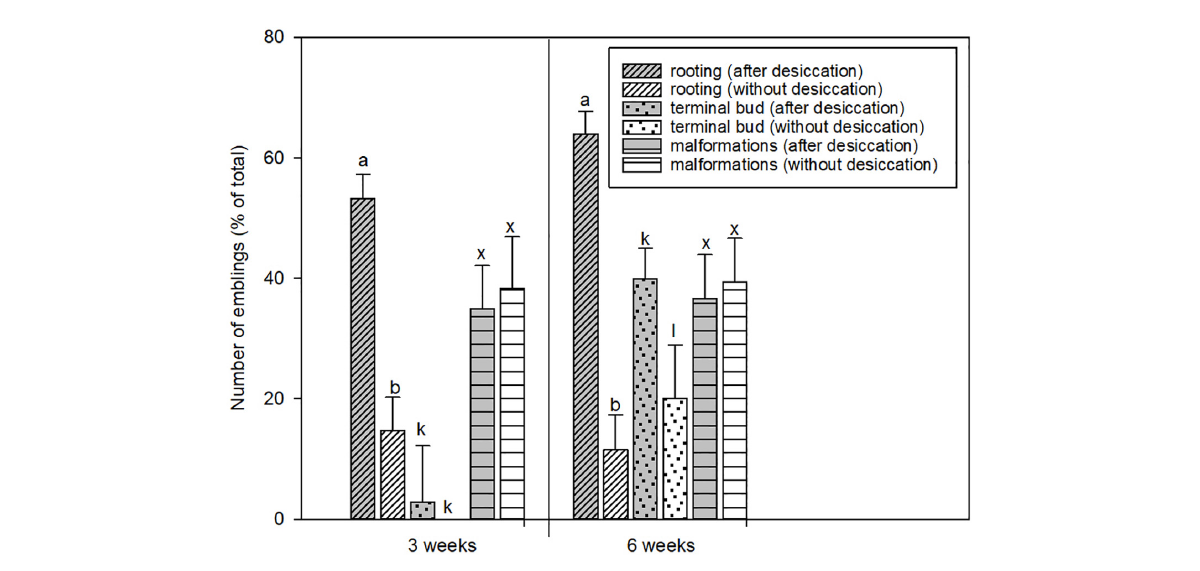
FIGURE2 The comparison of the development of somatic embryos from the first series of experiments with or without the desiccation phase. The proportion of the emblings with primary root, with growing terminal bud, and malformed emblings was evaluated after 3 and 6 weeks of germination in response to desiccation (gray columns) and without treatment (white columns). Values are expressed as means ± standard deviations ( n = 12) from two independent experiments. Different letters above columns indicate a statistically significant difference at p ≤